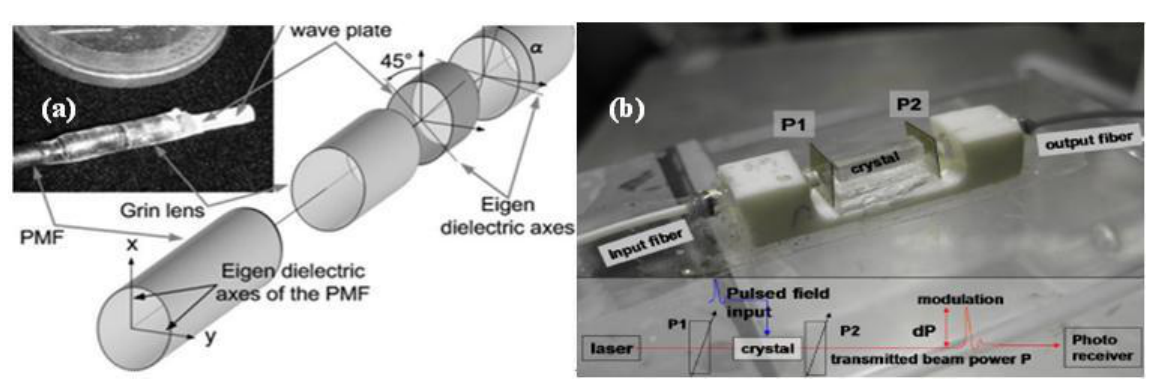
Figure 2. ( a ) Miniature Pockels Cell [34] (Copyright © 2008 OSA, Reprinted with permission); ( b ) Pockels Cell based on KDP crystal [41] (Copyright © 2011 IEEE, Reprinted with